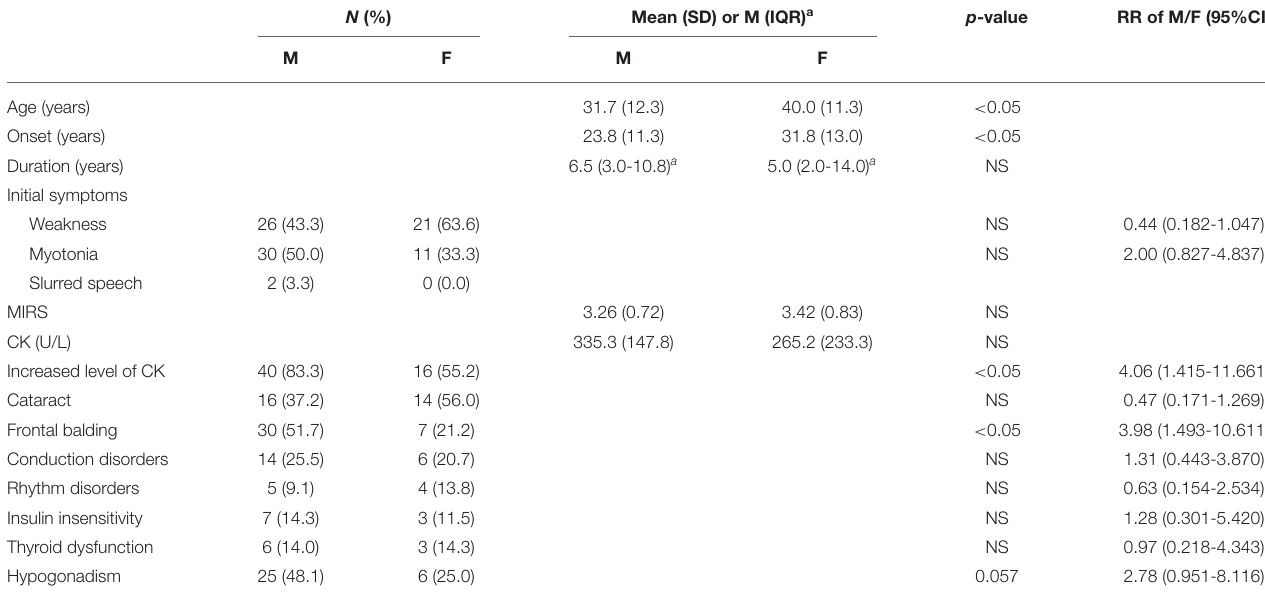
TABLE 1 | Summary of available clinical data on the DM1 cohort of study.